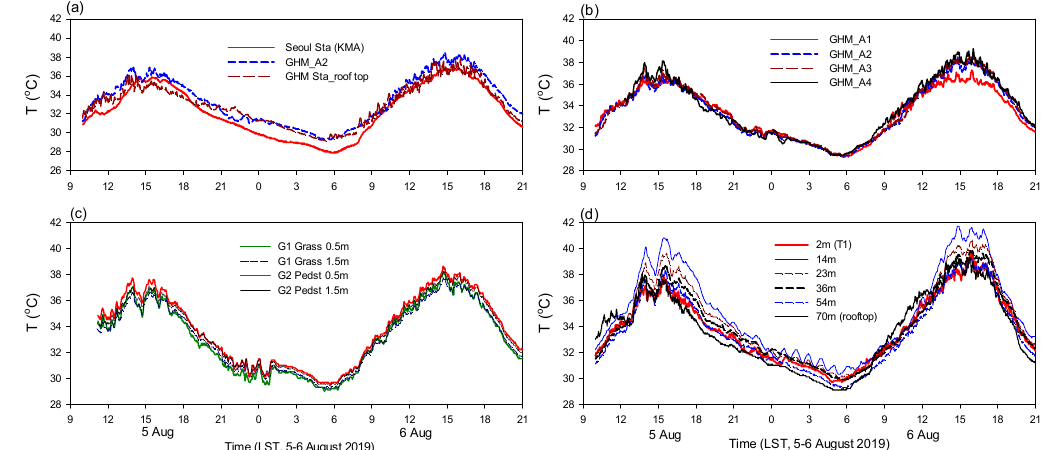
Figure 10. Time series of air temperatures observed at ( a ) the Seoul ASOS Station, GHM_A2, GHM station (rooftop of Building D), ( b ) GHM_A1, A2, A3, and A4, ( c ) GHM_G1 and G2 at heights of